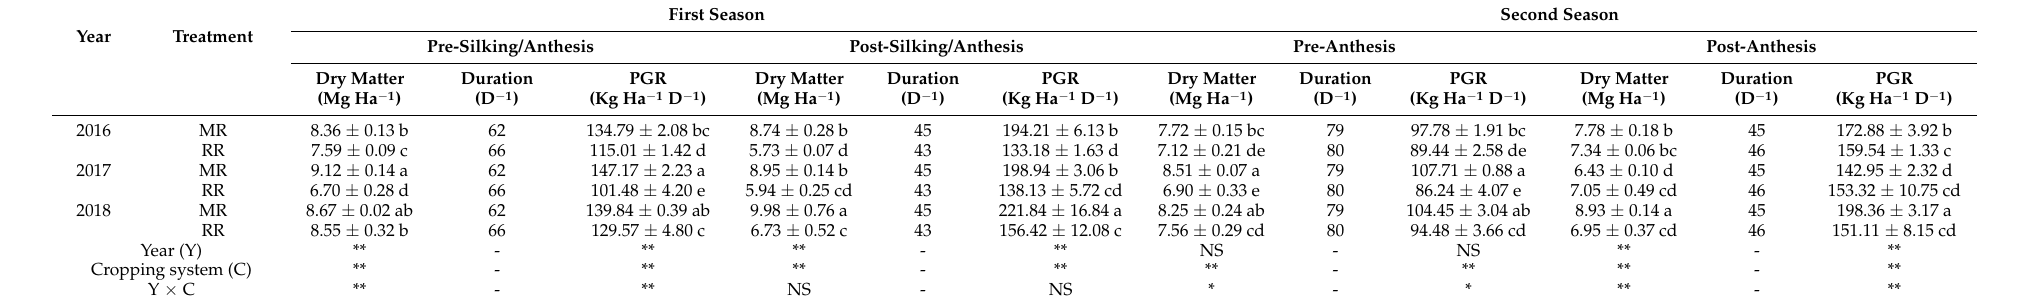
cropping system. Table 6. Dry matter, growth duration, and plant growth rate (PGR) during pre- and post-silking under maize in MR and pre- and post-anthesis under rice under MR and RR treatments in Jingmen from 2016 to